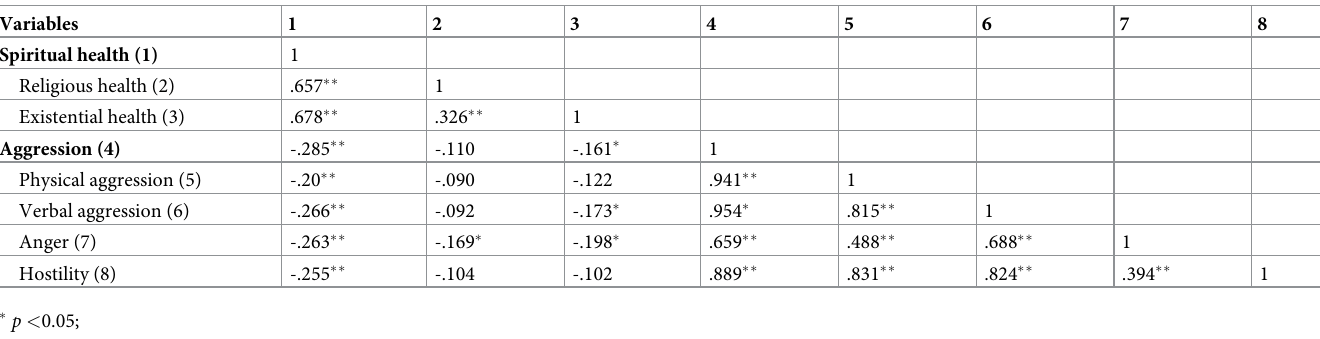
Table 3. Correlation coefficient between aggression and spirituality.